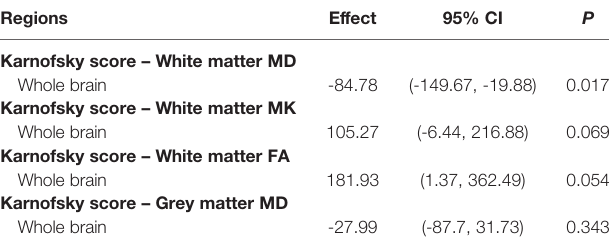
TABLE 2B | Multiple regression analysis of the relationships between Karnofsky score and diffusion metrics of the whole brain. Regions